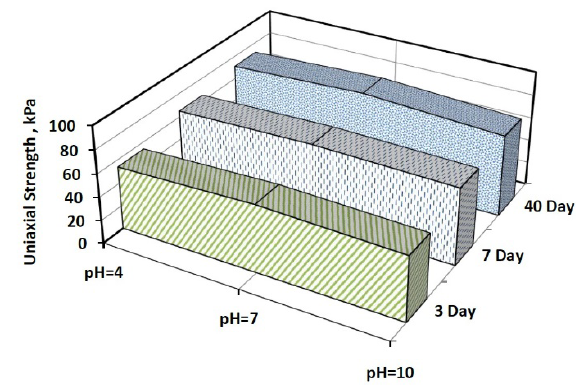
Figure 9: Unconfined compressive strength of samples stabilized by 5% cement in various environments in terms of